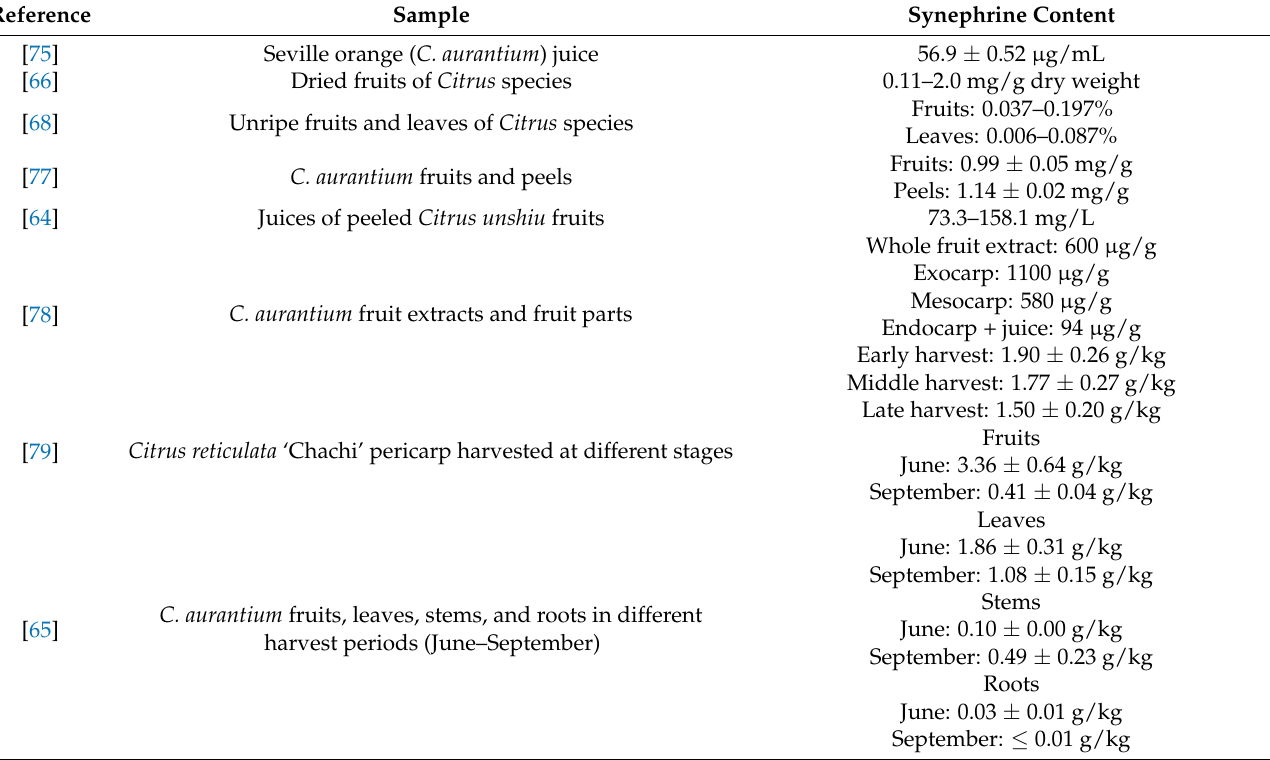
Table 2. Content of synephrine found in different Citrus